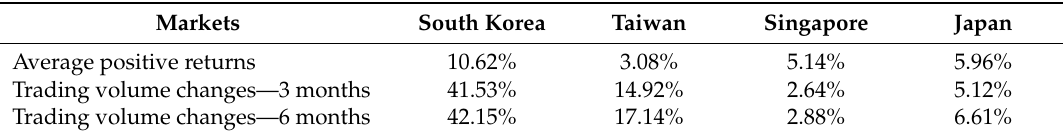
Table 5. Trading volume responses to positive return